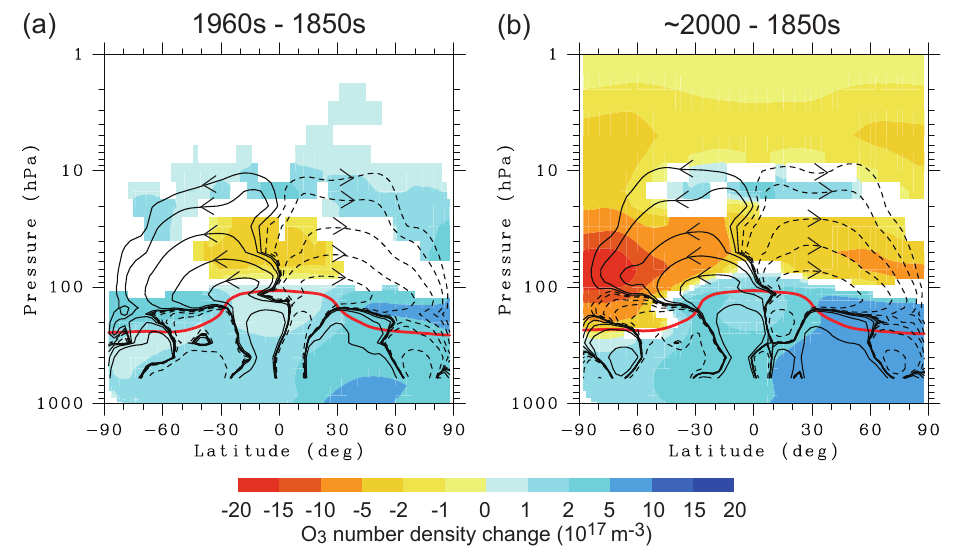
Fig. 2. Changes in the annual and zonal mean ozone number density between (a) the 1960–1969 and the 1850–1859 averages, and (b) 1996– 2005 and the 1850–1859 averages, in the GHGo simulation. The color shading is omitted where the change is less than the 95% confidence level. The contours show anomalous residual mean mass stream function corresponding to these periods, which indicate an acceleration of the Brewer-Dobson circulation in the lower stratosphere. The red curves show the tropopause diagnosed using the temperature lapse late.